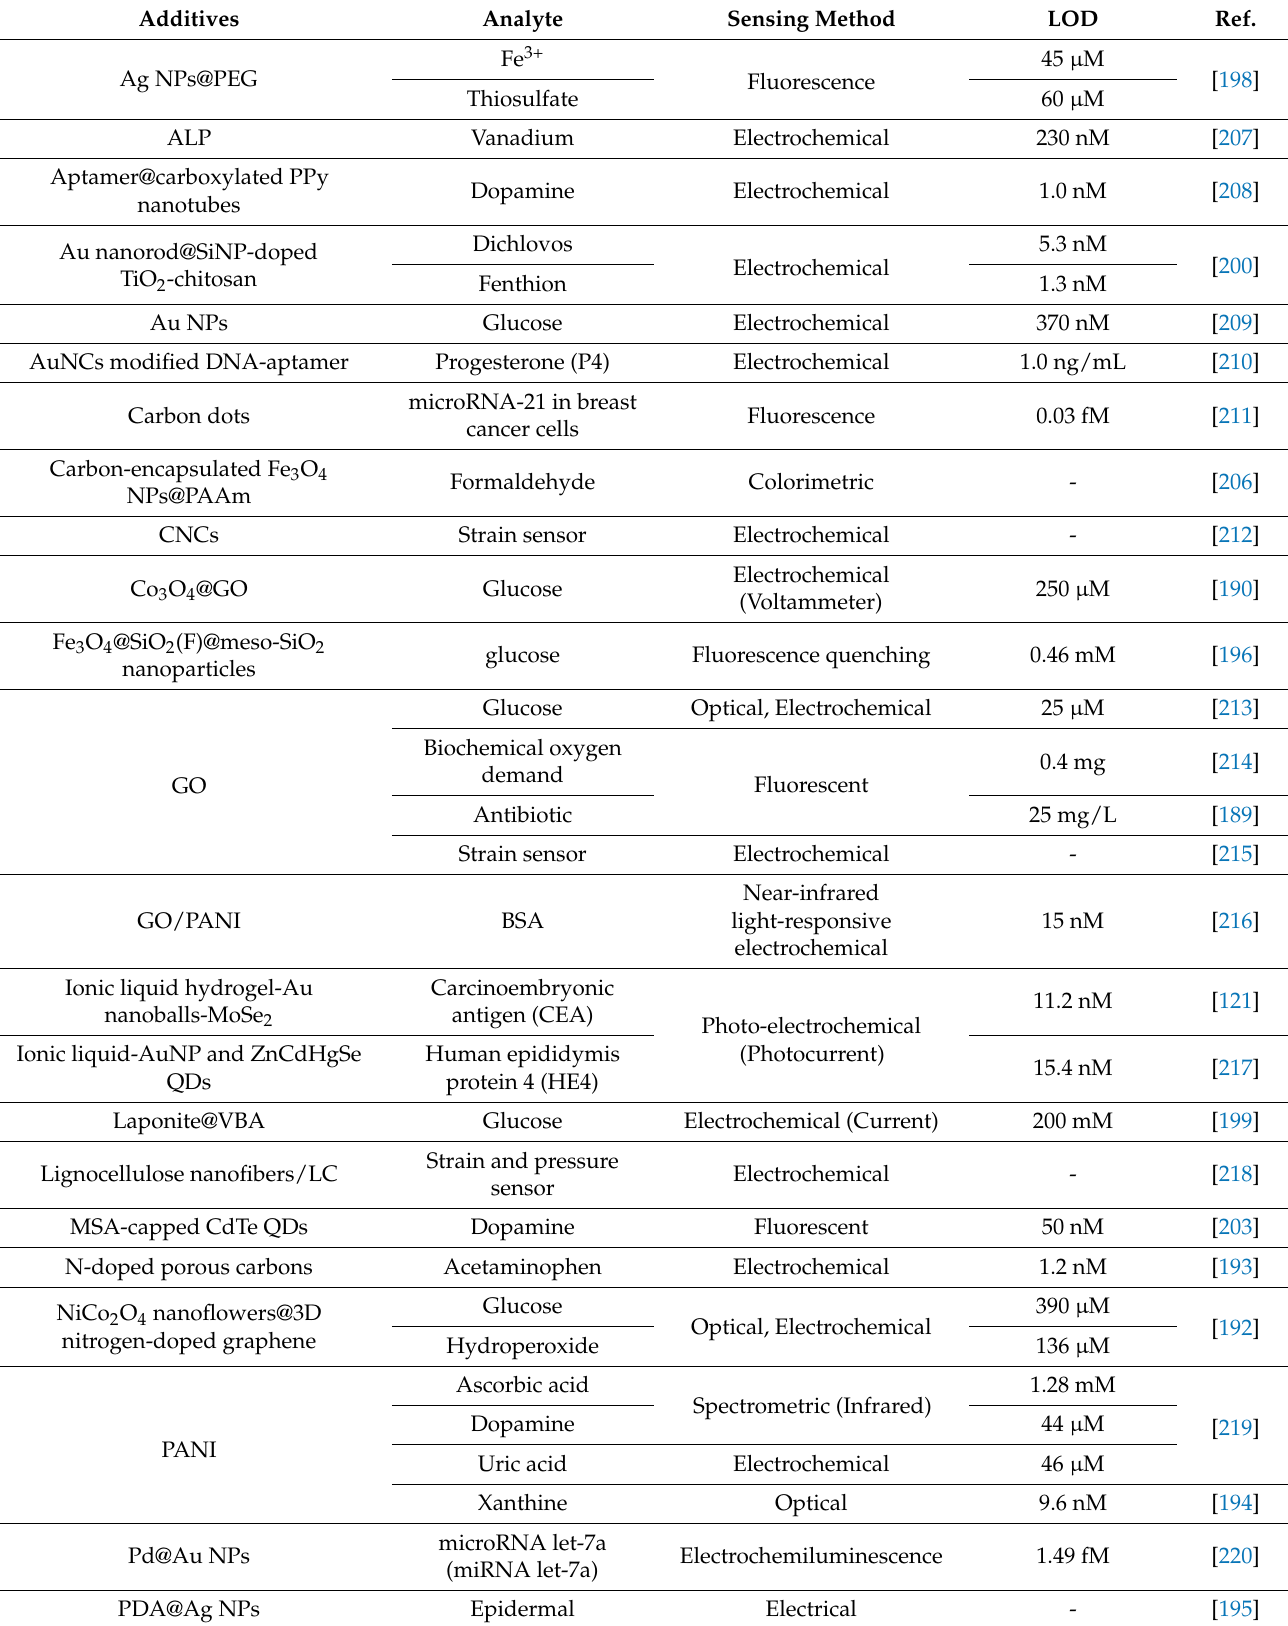
Table 5. Collection of some of the pertinent nanocomposite hydrogel applications for biosensing. Additives Analyte Sensing Method